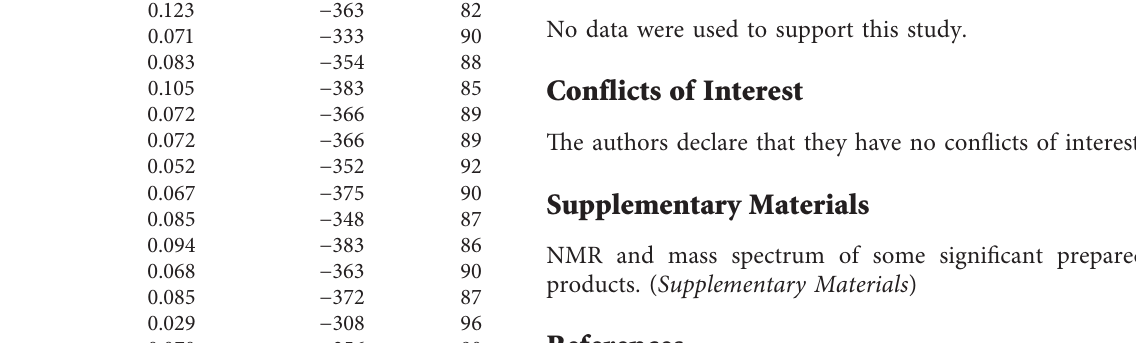
S300 steel in a 1 M HCl solution at 10 − 3 M. The maximum inhibition efficiency was found to be around 96%, and the inhibitors revealed a mixed behavior.